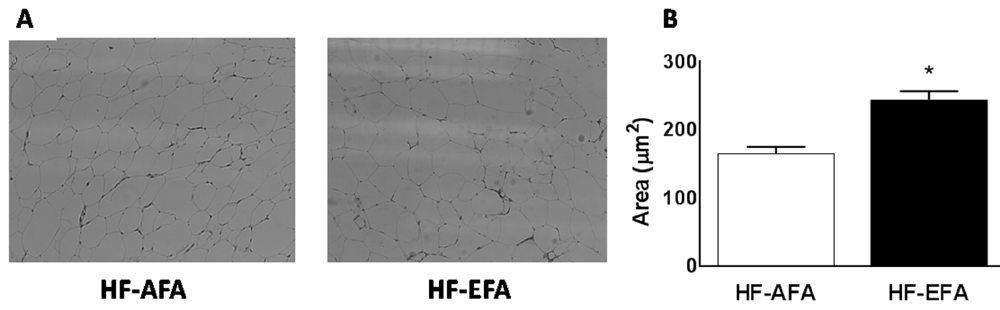
Figure 4. HF-EFA fed rats had larger adipocytes than HF-AFA fed rats. ( A ) Adipose tissue histology after H and E staining; ( B ) adipocyte size was quantified using ImageJ software. Values are means ± SEM, * p < 0.05. Nutrients 2016 , 8 , 594